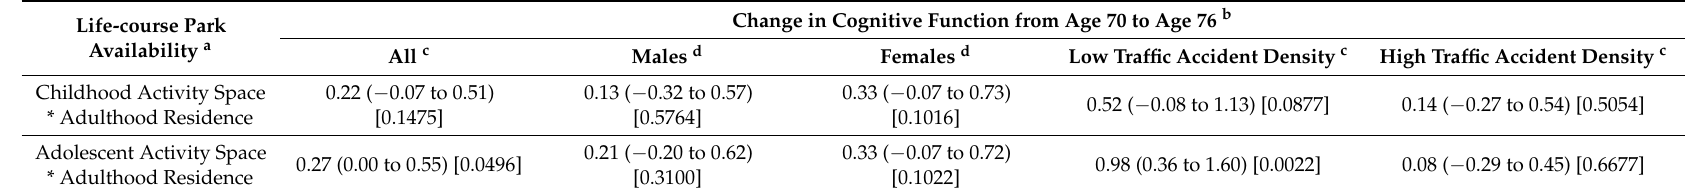
Figure 3. The marginal effects of the activity space park availability on cognitive change from age 70–76, by age period: ( a ) Childhood (age 4–11); ( b ) Adolescence (age 11–18). Table 2. The life-course analysis on childhood (age 4–11) and adolescent (age 11–18) park availability and cognitive change in later life.